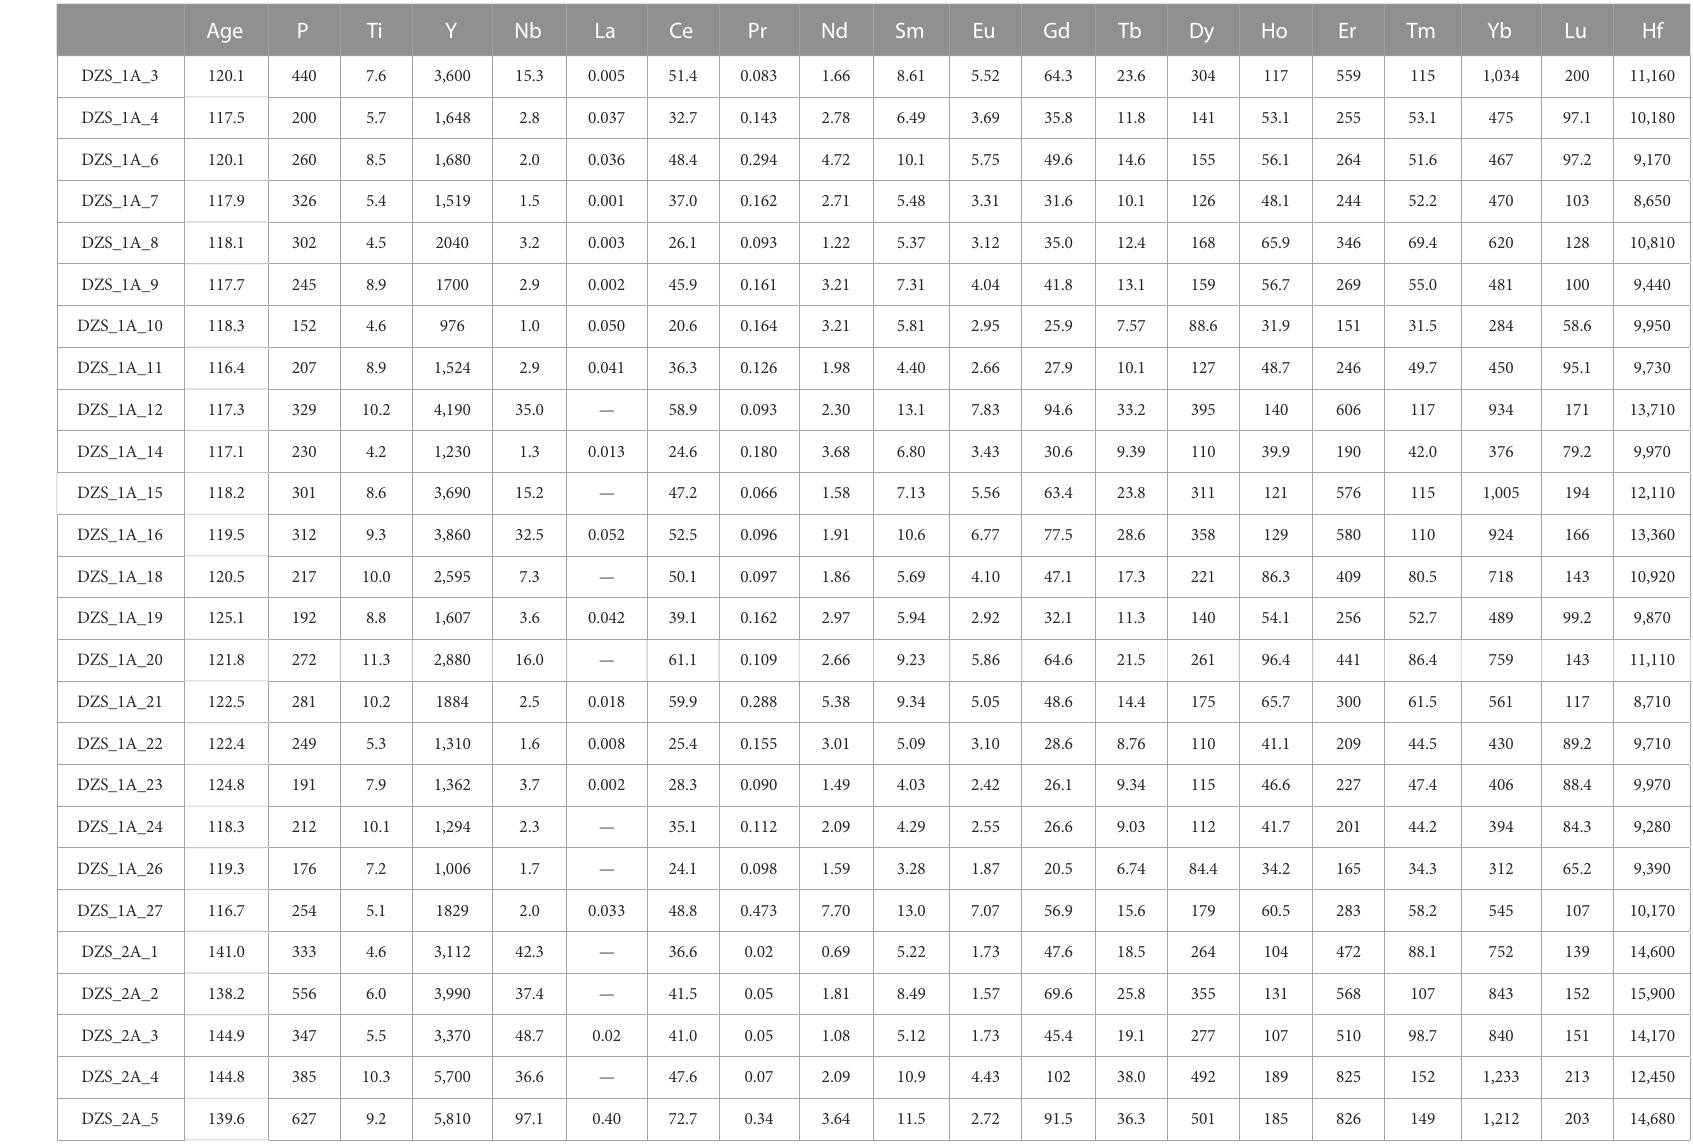
TABLE 3 Zircon trace element data for zircons from Dazeshan magmatic